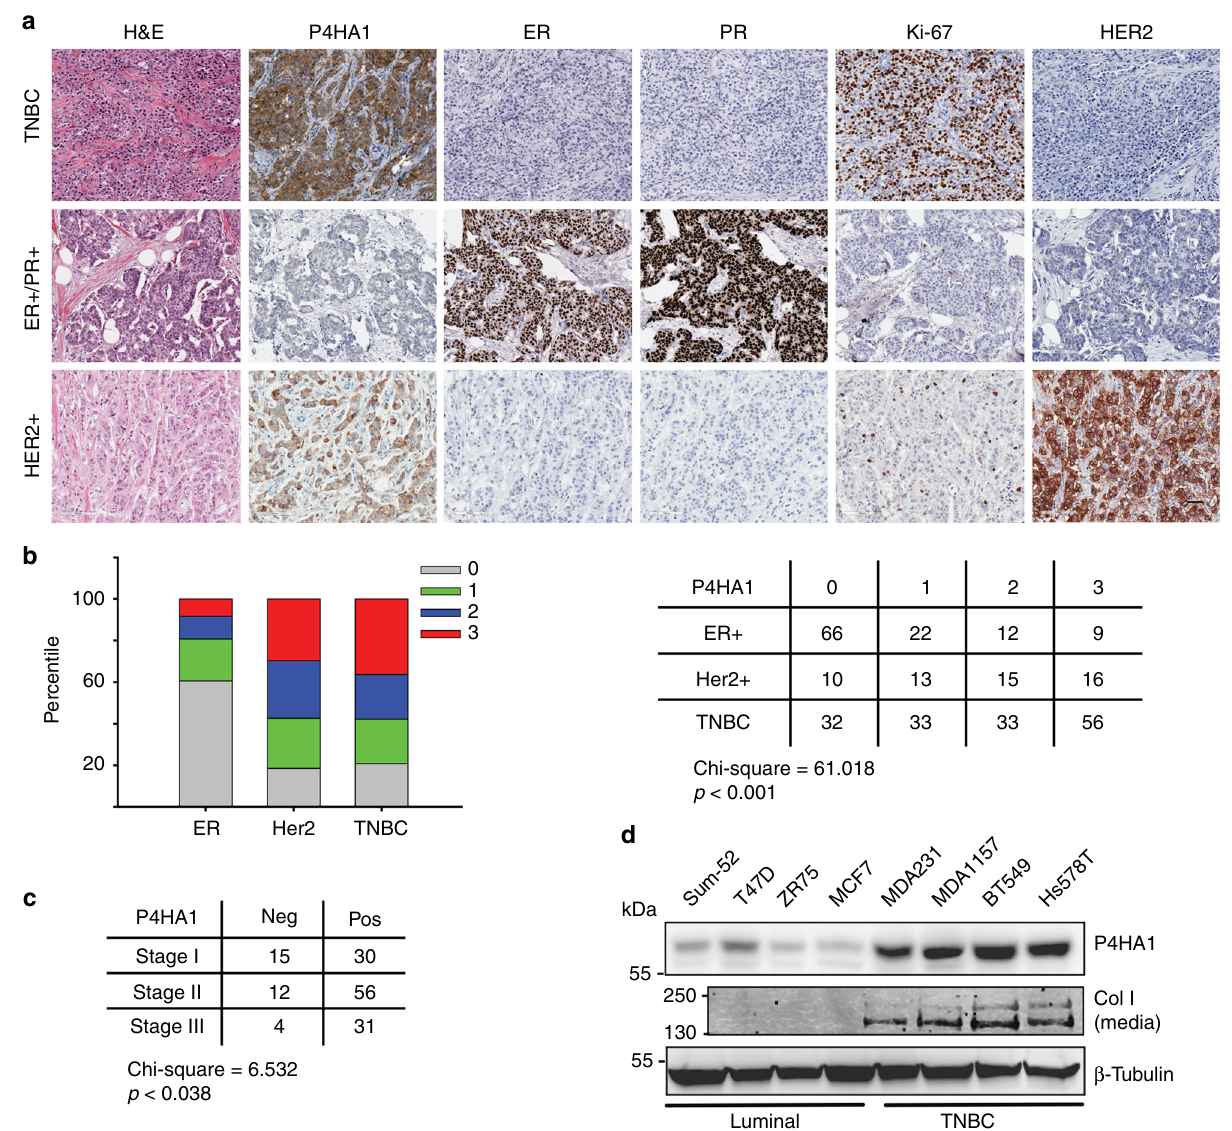
Fig. 1 P4HA1 protein levels are signi fi cantly increased in TNBC. a Human breast cancer tissue array was stained by H&E and immunohistochemistry for ER, PR, P4HA1, Ki-67, and HER2. Bar: 40 µ m. b , c Quanti fi cation of P4HA1 staining from a . The data were analyzed by χ 2 test. d P4HA1 protein levels and collagen secretion were assessed in a panel of breast cancer cell